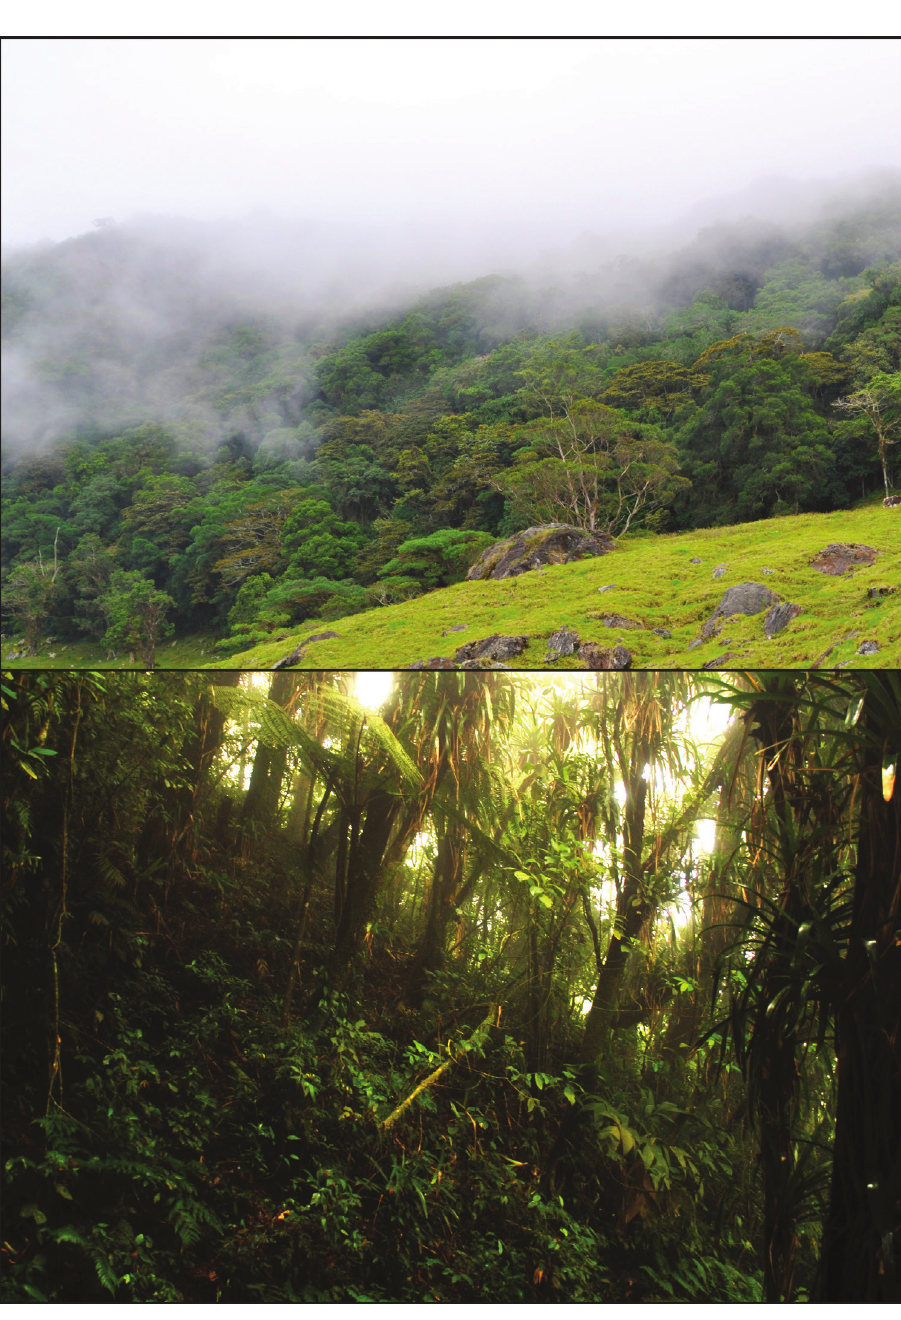
Figure 5. Type locality (top) and habitat (bottom) of Oreosaurus serranus sp. n. in the Sierra Nevada de Santa Marta, Colombia. Photos: Jhon Jairo Ospina-Sarria (top) and S.M.S